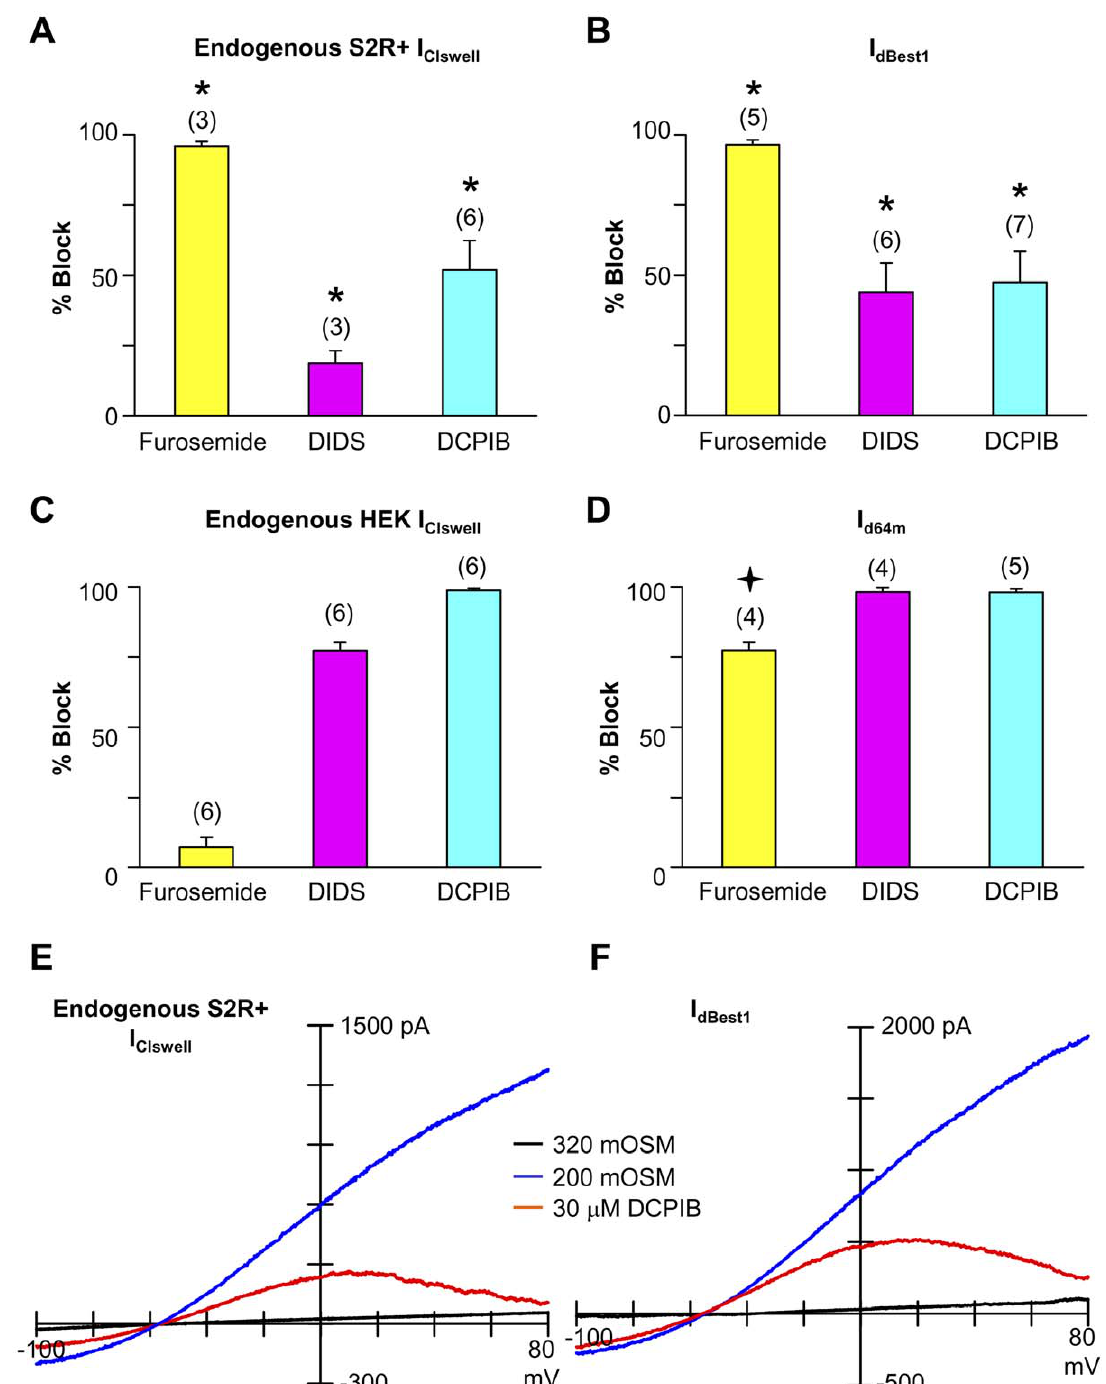
Figure 2. Pharmacological profiles of S2R + I Clswell and I dBest1 match and differ from those of HEK I Clswell and I d64m . (A–D) % Block of S2R + I Clswell , I dBest1 , HEK I Clswell and I d64m by 1 mM furosemide, 100 m M DIDS, and 30 m M DCPIB. Block at 0 mV is presented to emphasize the incomplete voltage-dependent DCPIB block of S2R + I Clswell and I dBest1 . (A) Steady state S2R + I Clswell activated by 200 mOSM stimulation was blocked 96% 6 1.6 by furosemide, 19% 6 4 by DIDS, and 52% 6 10.6 by DCPIB. * no difference compared to I dBest1 block and significantly different compared to HEK I Clswell and I d64m (ANOVA, p , 0.05). (B) I dBest1 , stimulated for 2 min by 200 mOSM, was blocked 96% 6 1.7 by furosemide, 44% 6 10 by DIDS, and 47% 6 10.9 by DCPIB. * no difference compared to S2R + I Clswell block and significantly different compared to HEK I Clswell and I d64m (ANOVA, p , 0.05). (C) Steady-state HEK I Clswell activated by 200 mOSM stimulation was blocked 7% 6 3.5 by furosemide, 77% 6 3 by DIDS, and 99% 6 0.7 by DCPIB. (D) Constitutive I d64m (320 mOSM) was blocked 77% 6 3 by furosemide, 98% 6 1.5 by DIDS, and 98% 6 1.2 by DCPIB. (cid:2) significantly different compared to S2R + I Clswell , HEK I Clswell and I d64m (ANOVA, p , 0.05). (E–F) I–V relations for S2R + I Clswell and I dBest1 demonstrate DCPIB voltage-dependent block. At 80 mV, DCPIB block of S2R + I Clswell is 90% 6 3.6 (n=6), and 82% 6 6.5 for I dBest1 (n=7).